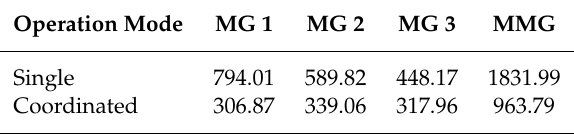
Figure 7. Unscheduled power exchange with the main grid. Table 3. Penalty cost of MGs in different cases